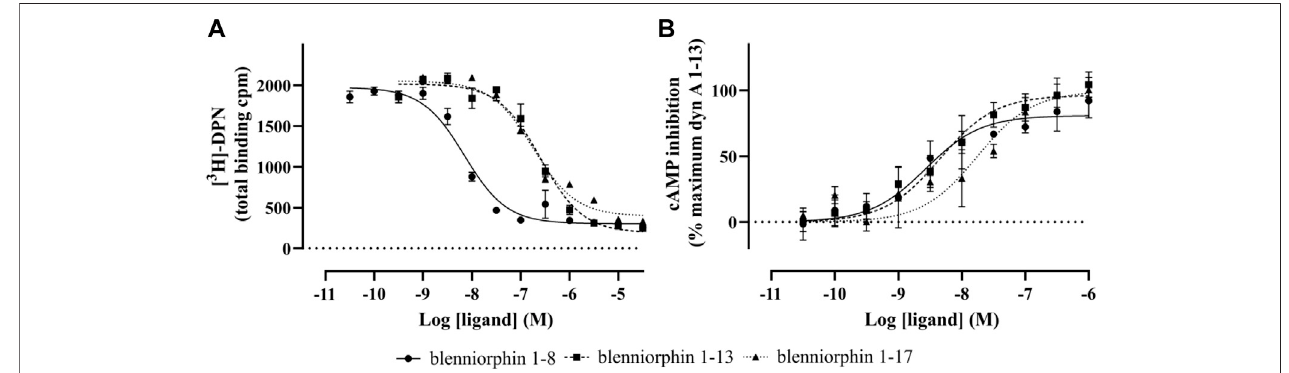
FIGURE3| RadioliganddisplacementandfunctionalcAMPassaysofblenniorphinsattheKOR. (A) Concentration-dependentdisplacementof[ 3 H]-diprenorphine (DPN, 1 nM) was measured by blenniorphins 1 – 8, 1 – 13, and 1 – 17 using HEK293 cell membrane preparations stably expressing mouse KOR. Total binding is shown in countspermin(cpm)anddataarepresented asmean ± SD( n (cid:2) 3).Nonspeci fi cbindingwasdetermined fromthecurve fi tandexperimentallyusing10 µMnaloxone. (B) FunctionalcAMPassaywasperformedon HEK293 cellsstablyexpressing mouseKOR. Forskolin(10 µM)wasusedfortheactivationofadenylylcyclase. Dataare normalized to 100% of dynorphin (dyn) A 1 – 13 measured at its saturating concentration (10 µM) and are shown as mean ± SD ( n (cid:2) 3).